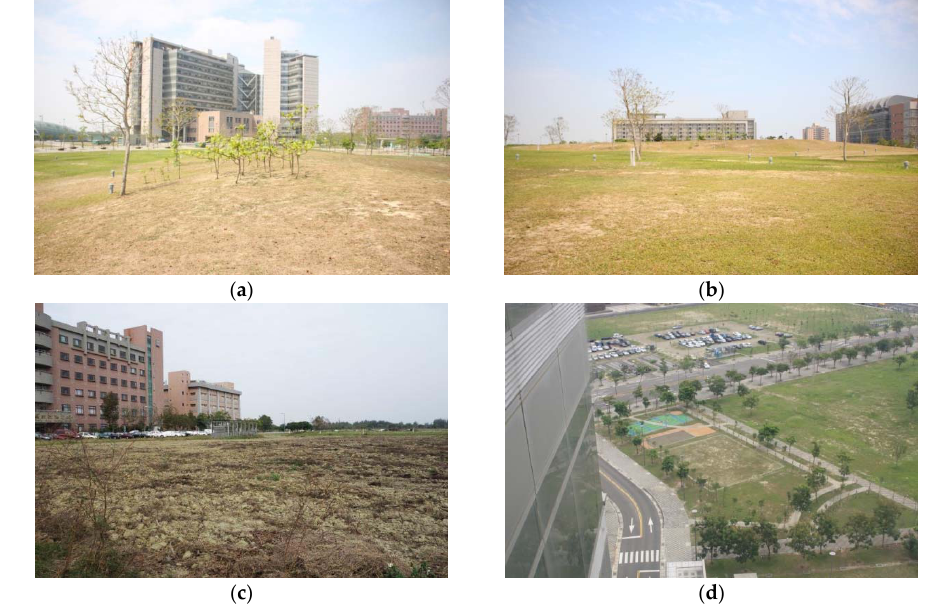
Figure 1. ( a – d ) Photos demonstrate the study site surroundings.